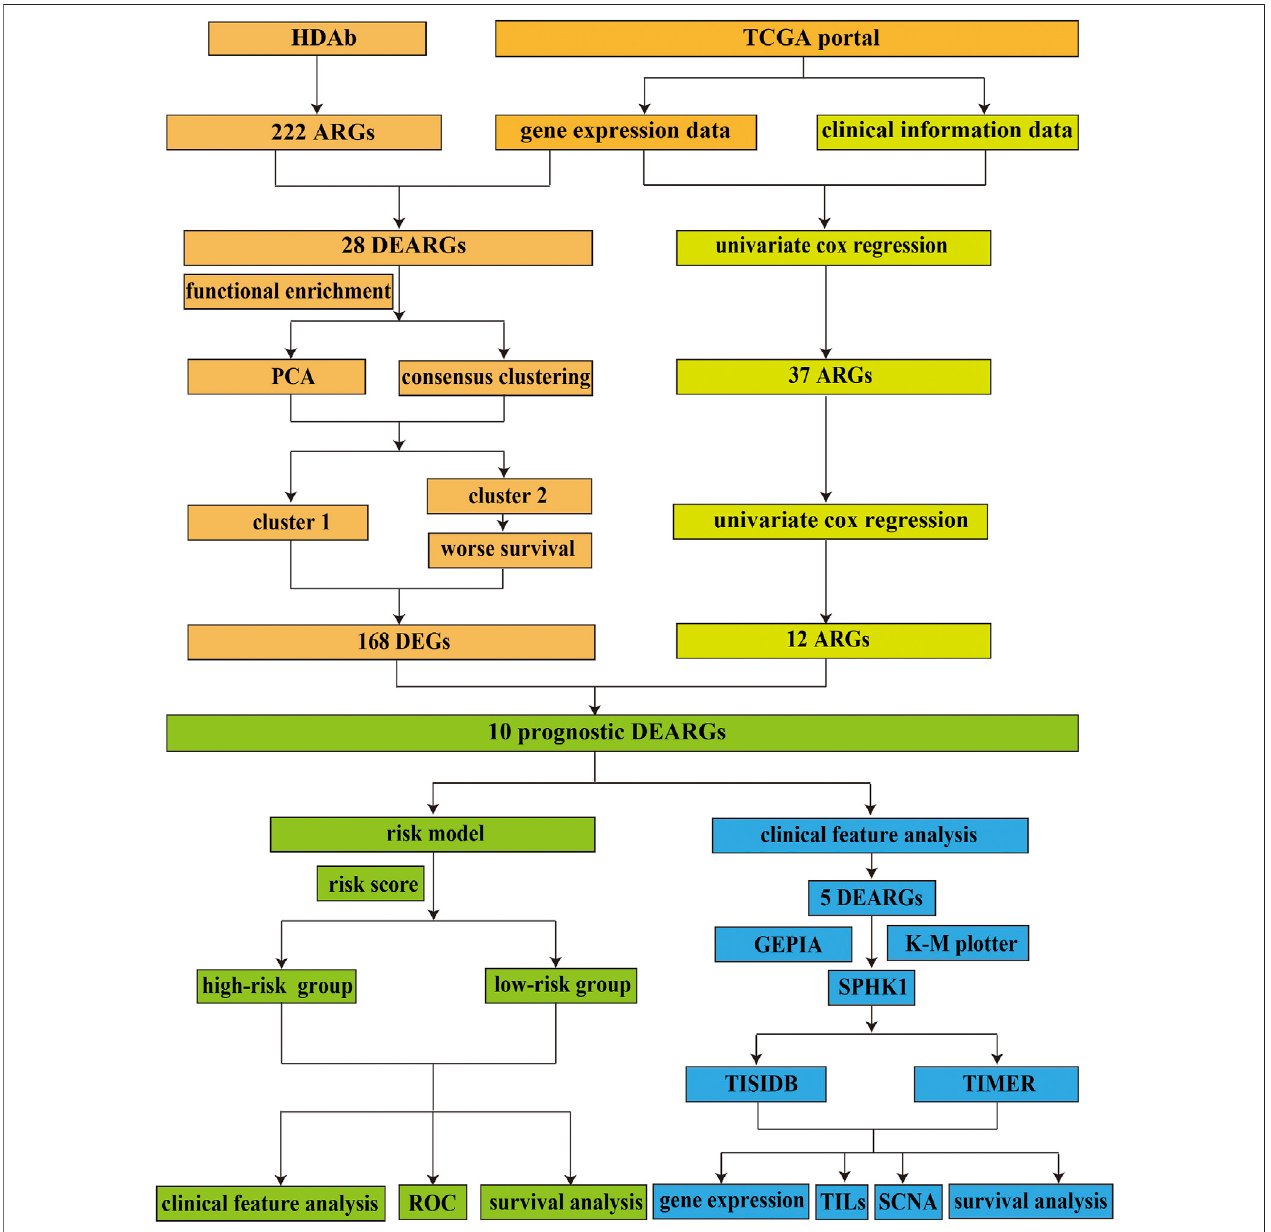
FIGURE 1 | Flowchart of the current study. HADb, Human Autophagy Database; TCGA, the Cancer Genome Atlas; ARGs, autophagy-related genes; DEARGs, differentially expressed autophagy-related genes; PCA, principal component analysis; DEGs, differentially expressed genes; ROC, receiver operating characteristic; GEPIA, Gene Expression Pro fi ling Interactive Analysis; K-M plotter, Kaplan – Meier plotter; TILs, tumor-in fi ltrating lymphocytes; SCNA, somatic copy number variation.